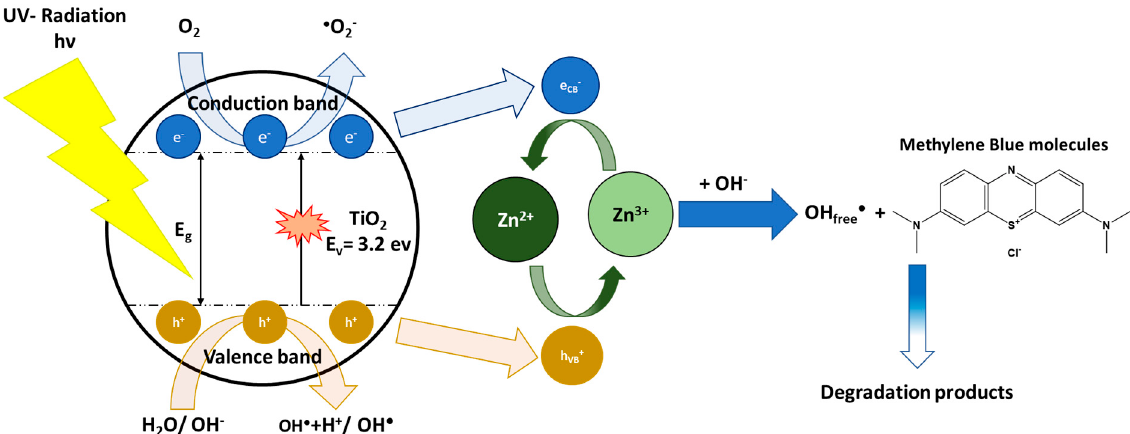
Figure 9. Schematic presentation of the methylene blue degradation mechanism under photocatalytic activation of TiO 2 in the presence of zinc ions in aqueous solution.